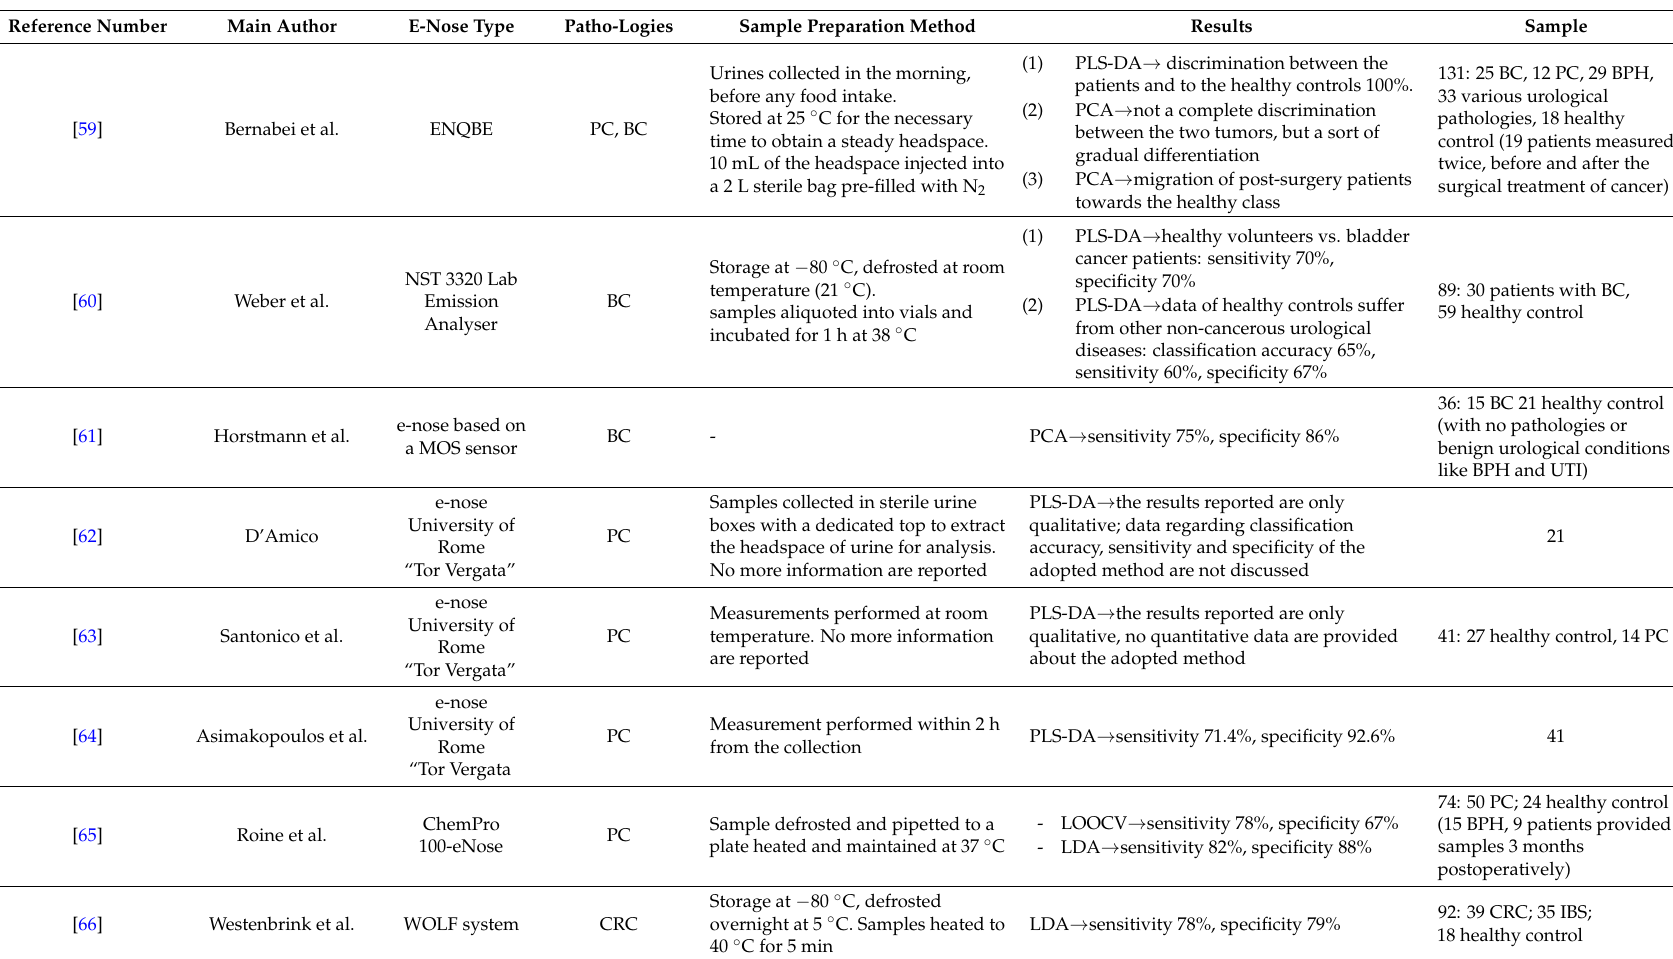
Table 4. Scheme of the studies regarding cancer